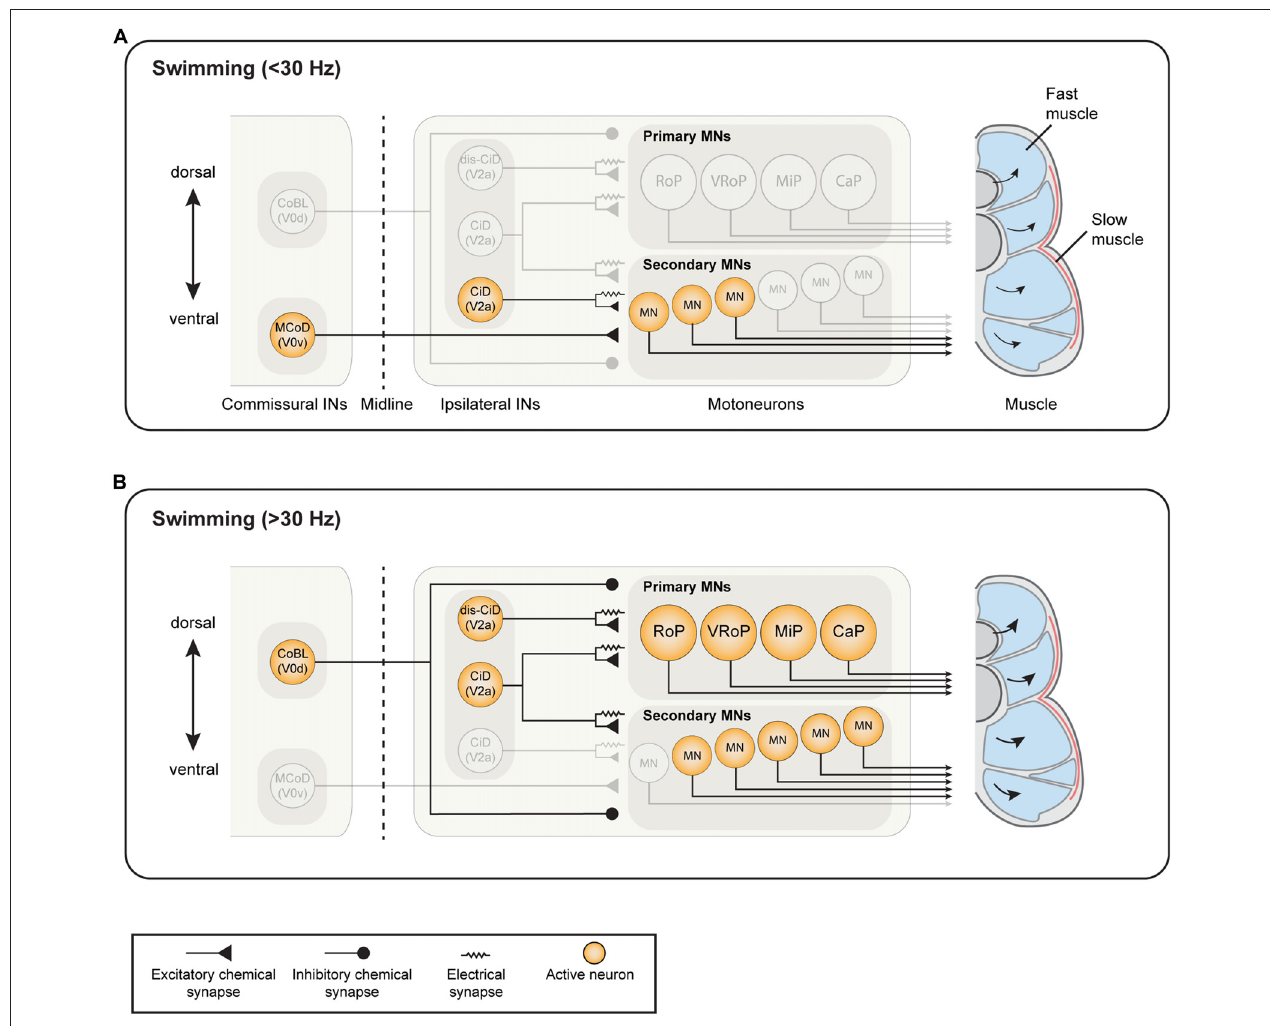
FIGURE 1 | Known active neuron types and established connectivity within the spinal swim central pattern generator (CPG) network of larval zebrafish. (A) During slow swimming ( < 30 Hz), only the most ventral motoneurons (MNs) are active, which receive excitatory drive from ventrally-located circumferential descending (CiD) interneurons (INs; ventral V2a INs). Commissural excitatory INs multipolar commissural descendings (MCoDs), a subtype of V0v IN, also provide excitation to secondary motor neurons from the contralateral side. (B) During fast swimming (>30 Hz), the ventral MNs remain active but more dorsal secondary MNs and primary MNs also become recruited. Both the ventral CiD and MCoDs are actively de-recruited, whereas the dorsally-located CiDs and displaced dorsal CiDs (dis-CiD) become active. The displaced CiDs provide selective excitation to primary motor neurons. Note that several IN types known to be active during swimming are not displayed as their roles are less well